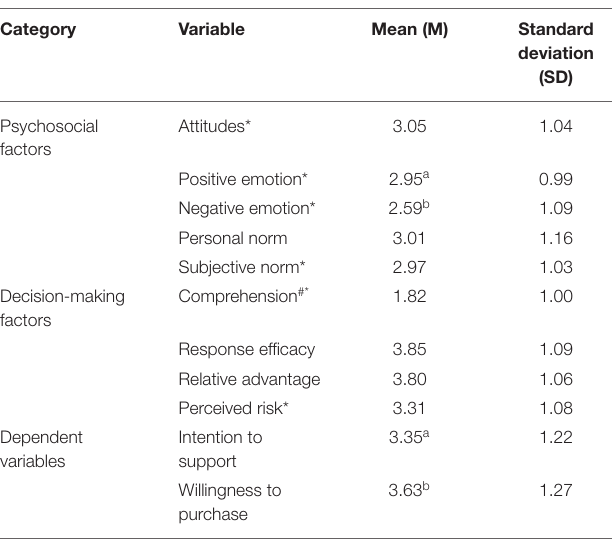
TABLE 2 | Means and standard deviations for the key psychosocial, decision-making and outcome variables.